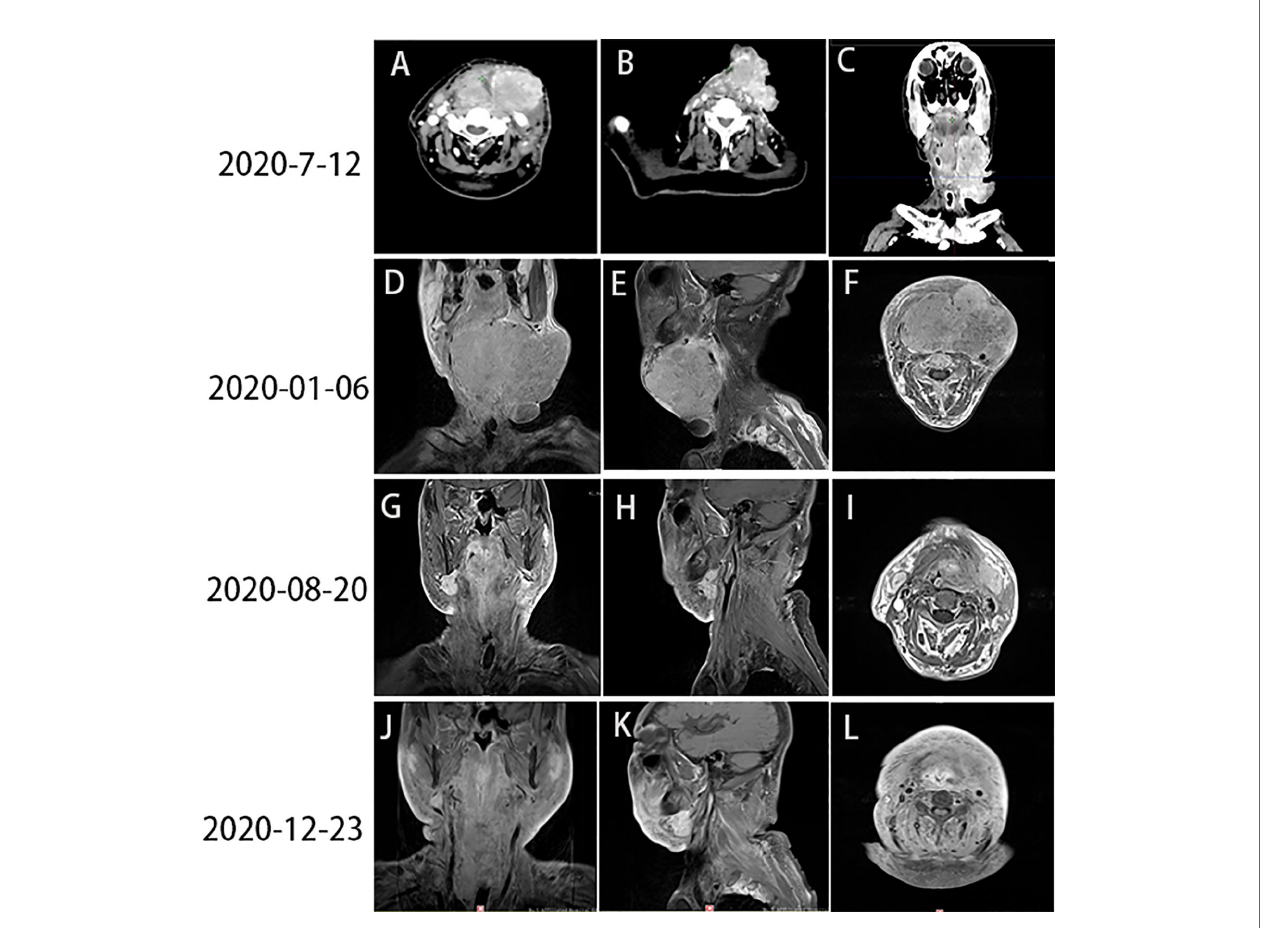
FIGURE 3 | (A – C) Head and neck CT revealed PD (June 12, 2020). (D – F) Images captured prior to radiotherapy (January 6, 2020). (G – I) Images captured after the end of radiotherapy (August 20, 2020). (J – L) The tumor mass had almost completely regressed by December 23, 2020. CT, computed tomography; PD, progressive